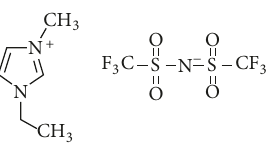
Figure 1: Molecular structure of [EMIM][TF 2